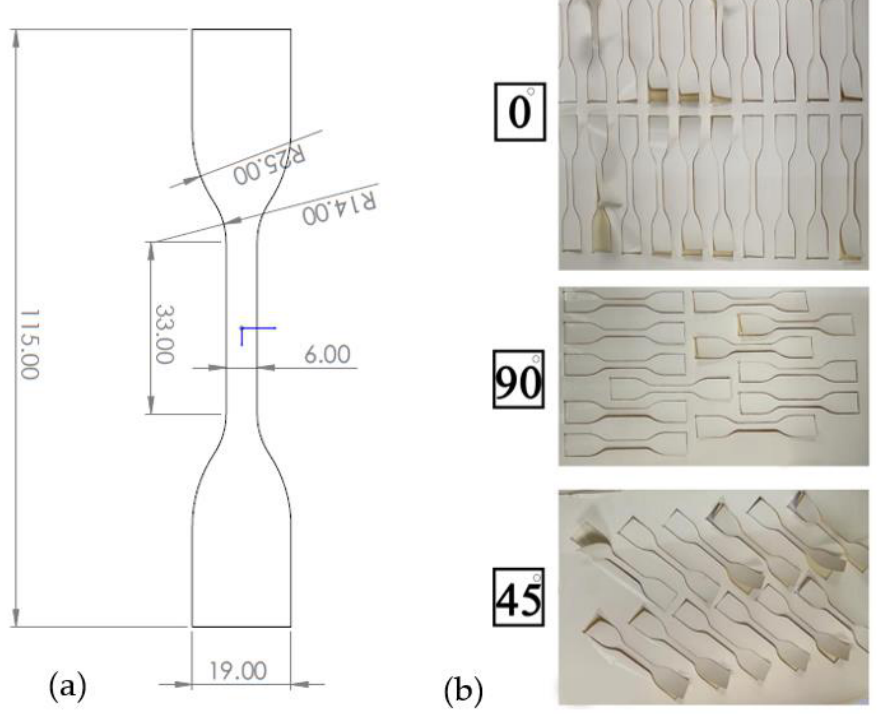
Figure 3. Tensile sample: ( a ) dimensions (mm) and ( b ) different cutting angle orienta- tions.